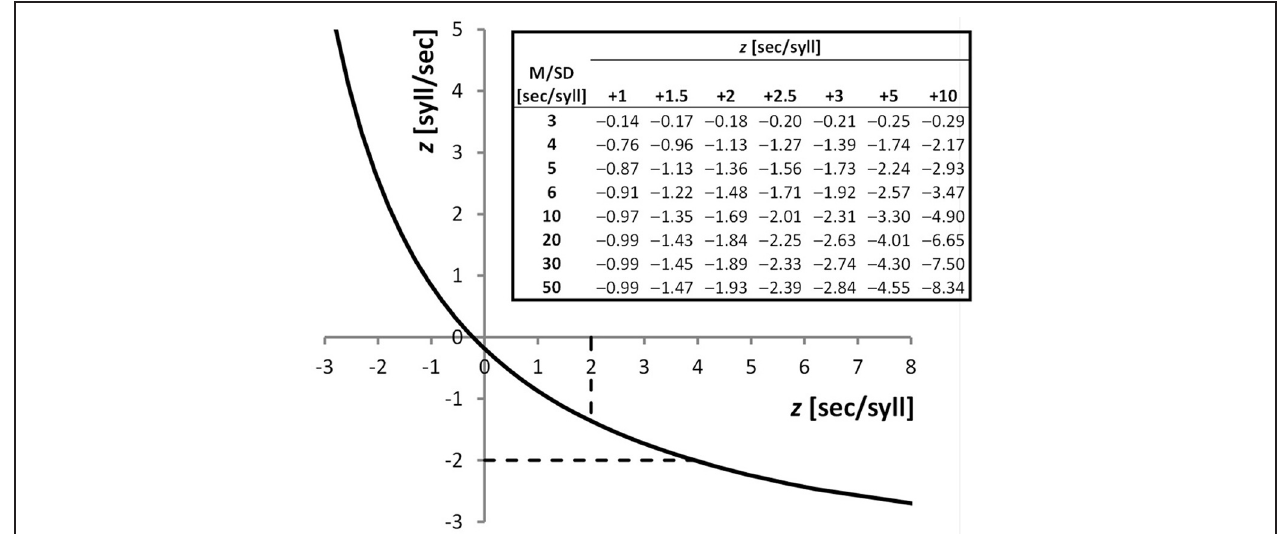
using sec/syll, and normal using syll/sec. Table : z -scores from the syll/sec scale as a function of z -scores from the sec/syll scale (different columns) and of the distribution of sec/syll scores (rows). Normal distributions of sec/syll scores were simulated ( N = 20,000), with different Mean/SD ratios (3–50). For instance, a child whose z -score from sec/syll is + 2, with the normative sample having a Mean/SD ratio of 6, has a z -score from syll/sec of −